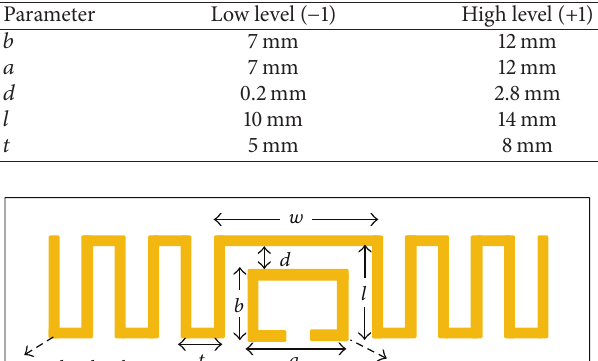
Table 1: Ranges for the design parameter of the inductive-feed meander dipole.